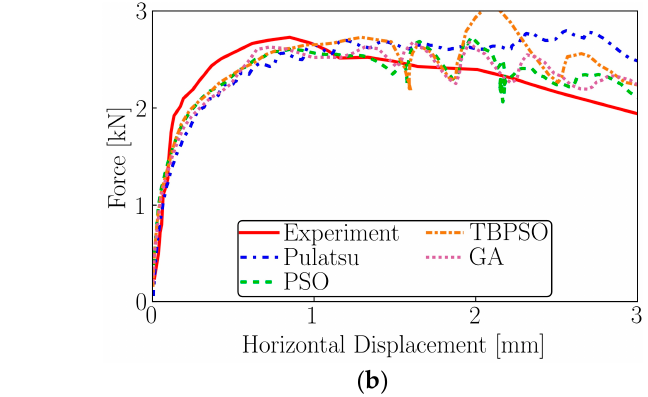
Figure 24. Calibrated material parameter load displacement diagrams of densely meshed geometry (objective function 2, PSO and GA: 50 iterations; TBPSO: 20 iterations): ( a ) vertical displacement, ( b ) horizontal displacement.